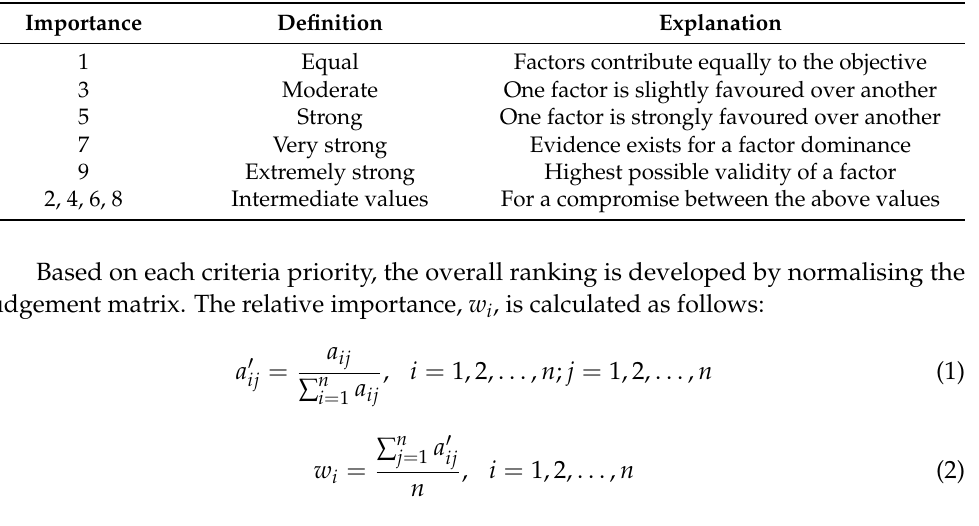
Table 1. Gradation scale for pairwise comparisons